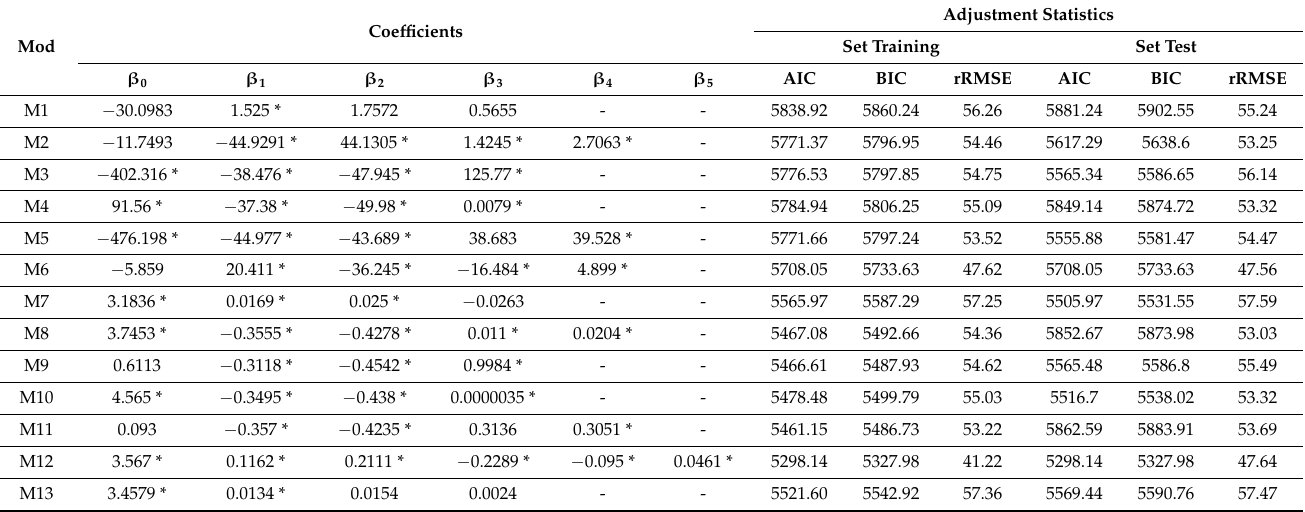
Figure 6. Randomized quantile residue plots of the six best-fit models. AC = area of the clearing; Phyto = phytophysiognomy; d = diameter at breast height; H = height; Dirrev = number of trees with irreversible damage; Dsev = number of trees with severe damage; log = logarithmic transformation. Table 5. Coefficients and precision statistics of generalized linear models to predict the clearing size in an area of planned forest exploitation in the Brazilian